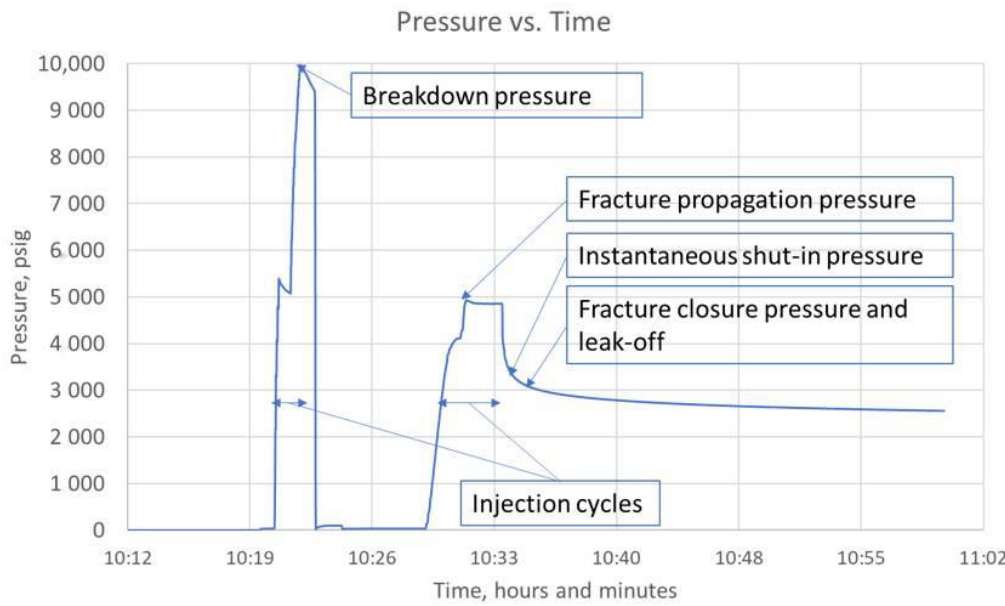
Figure 5. Field diagnostic fracture injection test (DFIT) pressure vs. time data for Well 3H. Energies 2020 , 13 , x FOR PEER REVIEW